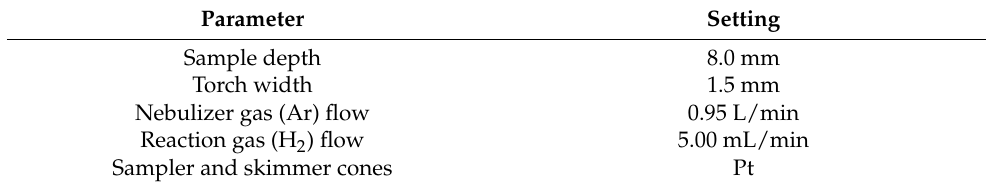
Figure 1. BF-STEM image ( A ) and magnetic properties ( B ) of synthesized nanoparticles. Table 1. Optimal SP-ICP-MS/MS